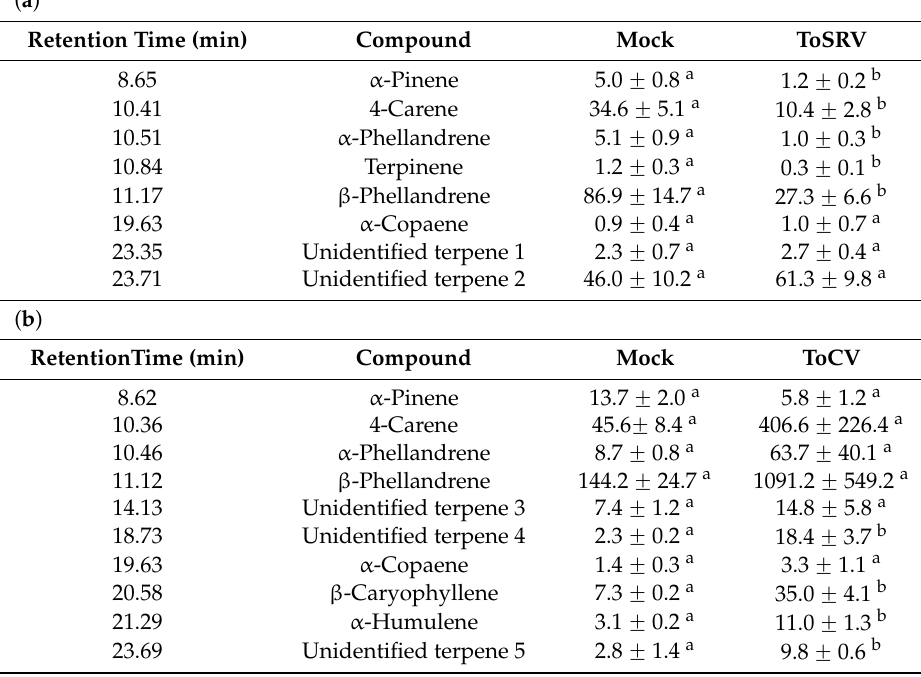
Table 3. Volatile emission of mock-inoculated and virus-infected plants (mean ˘ SE ng ¨ g ´ 1 leaf tissue ¨ h ´ 1 ) * ( a ) mock-inoculated and ToSRV-infected plants and from ( b ) mock-inoculated and ToCV-infected